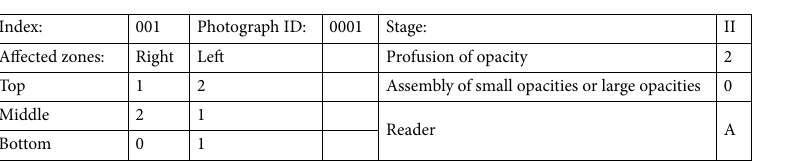
Table 4. Example of record form filled by each group of radiologists for